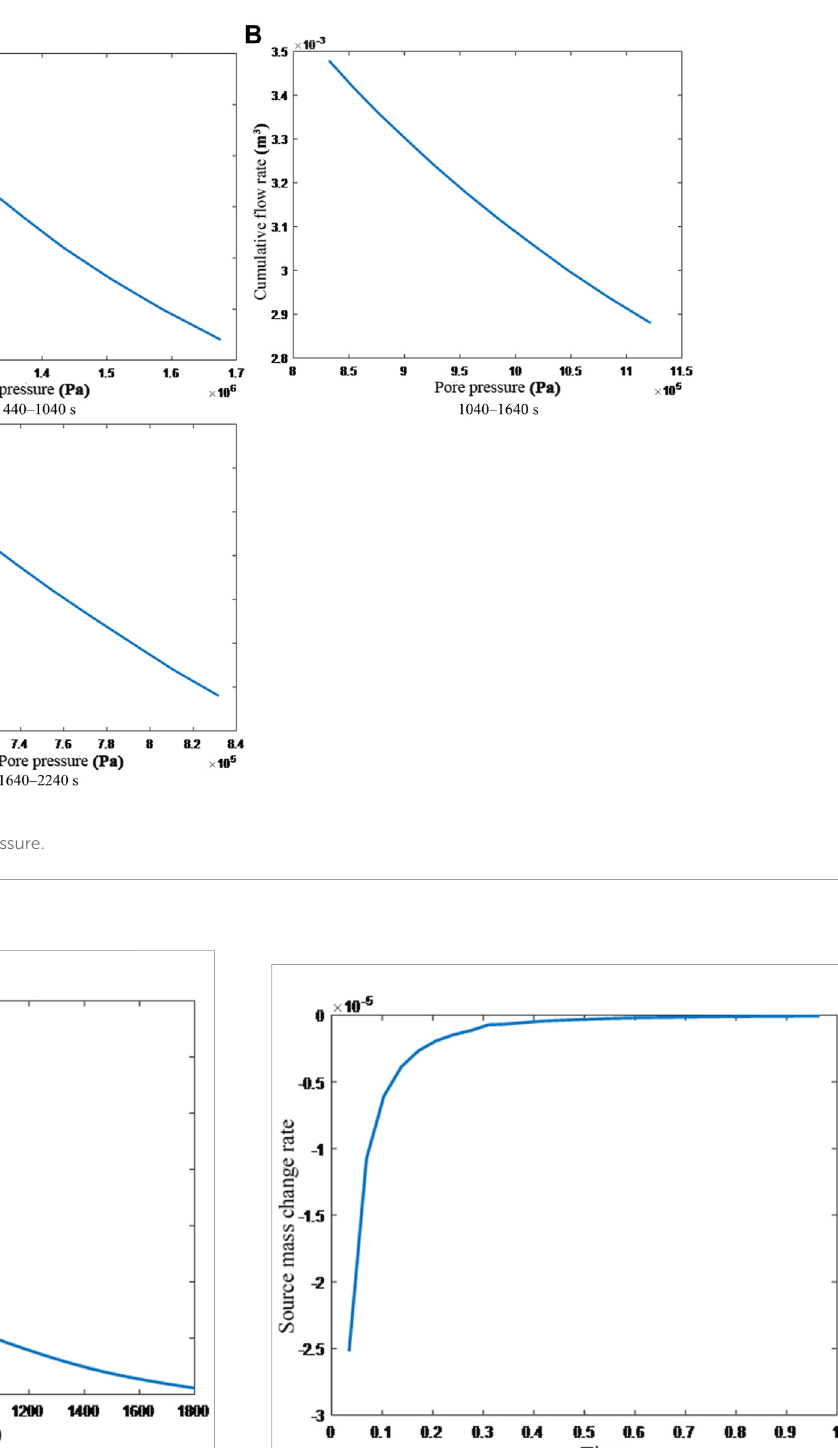
FIGURE 10 Identi fi ed source function. FIGURE 11